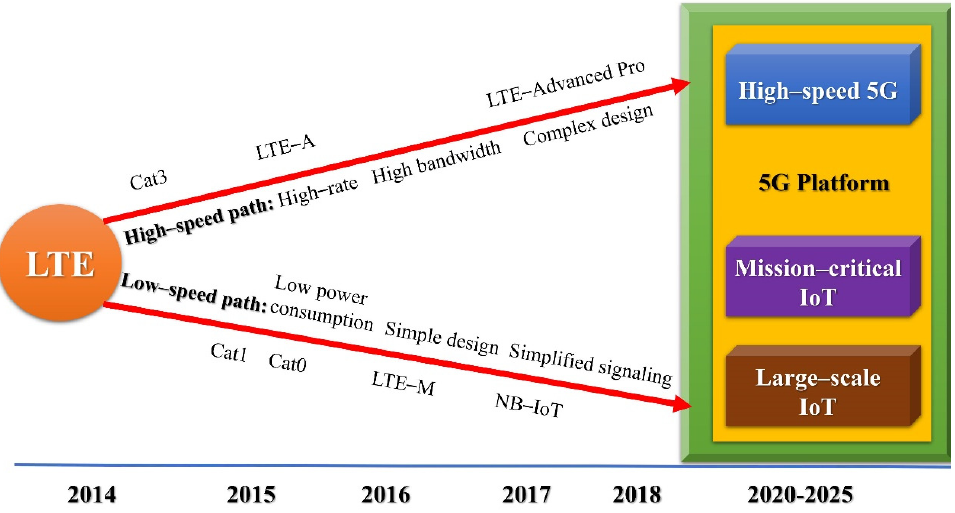
Figure 3. Evolutionary branches of mobile communication.